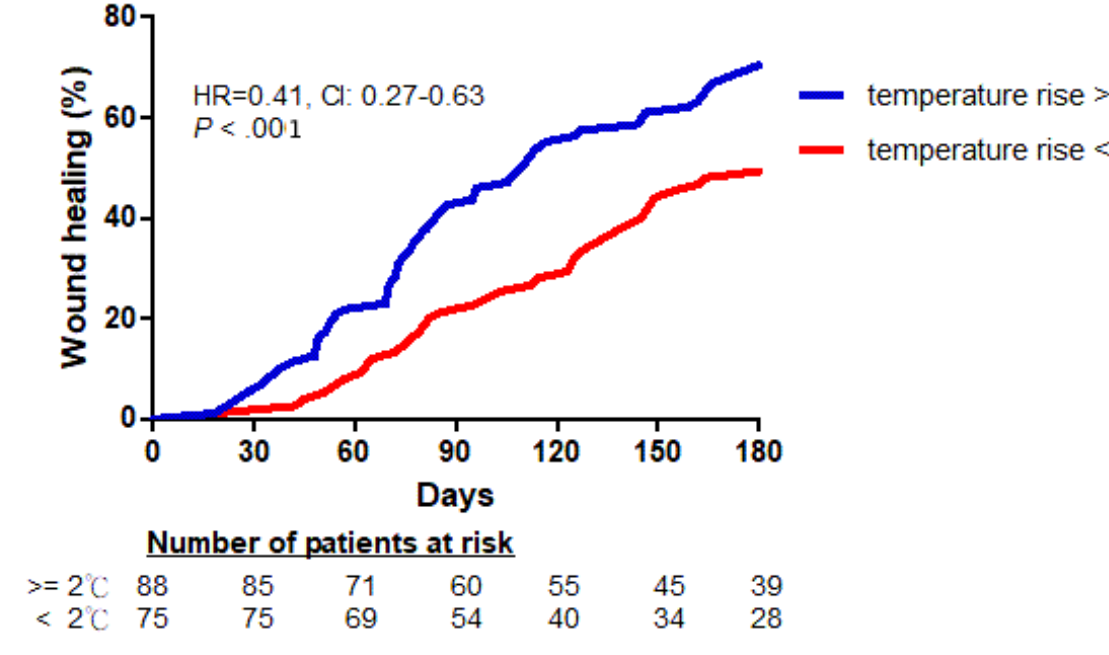
Figure 3. Wound healing time Kaplan-Meier curves (log-rank test P =.01; for trend P <.007). HR: hazard ratio.